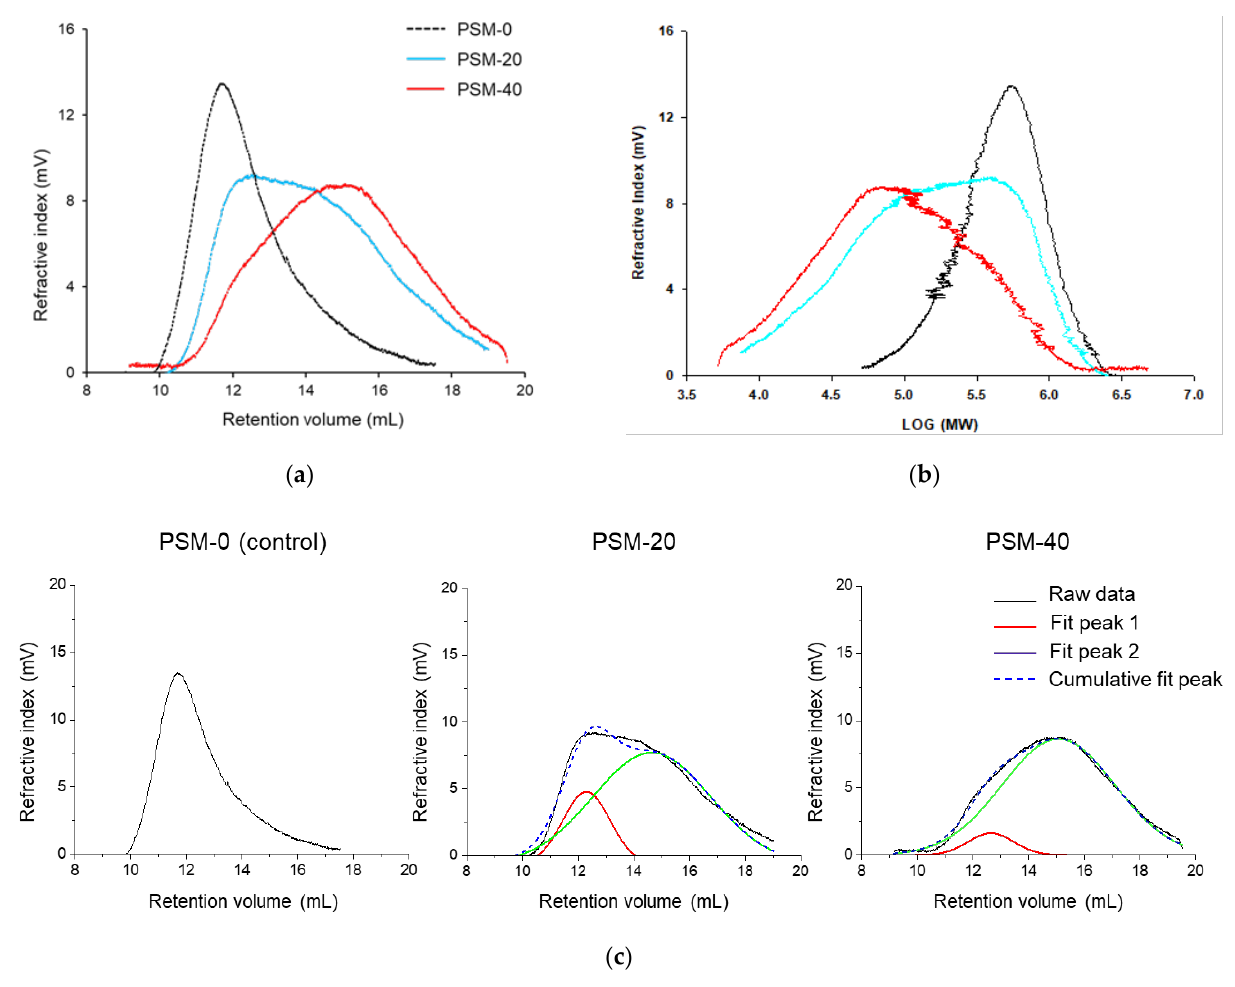
Figure 3. Representative gel permeation chromatography (GPC) data of the control and plasma surface modified (PSM) cotton cellulose. ( a ) Refractive index vs. retention volume, ( b ) Refractive index vs. log MW of cotton cellulose subjected to plasma treatment for 0 min (PSM-0), 20 min (PSM-20), and 40 min (PSM-40) and, ( c ) Peak deconvolution of refractive index vs. retention volume curves of PSM-0, PSM-20, and PSM-40 cotton cellulose. Table 1. Weight averaged molecular weight (M W ), number averaged molecular weight (M n ), degree of polymerization (DP), and PDI of cellulose in the control (PSM-0) and plasma treated (PSM-20 and PSM-40) cotton fibers (average of three